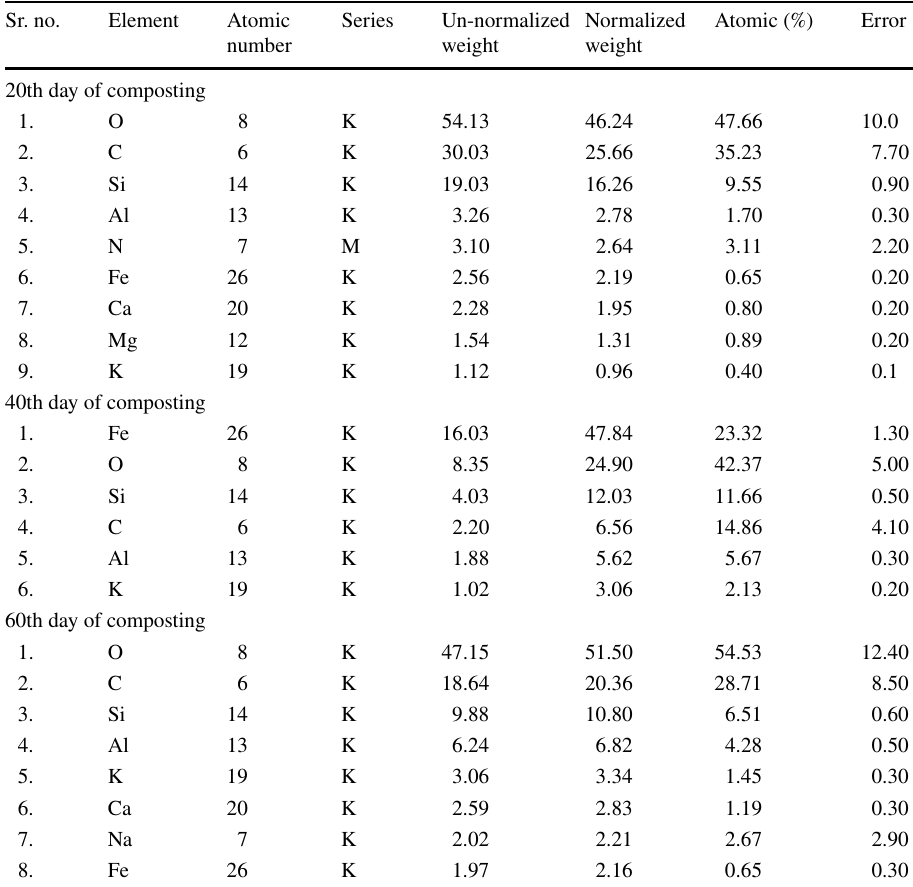
Table 11 SEM quantitative analysis of detected elements in 20th, 40th, 60th days (Mandi